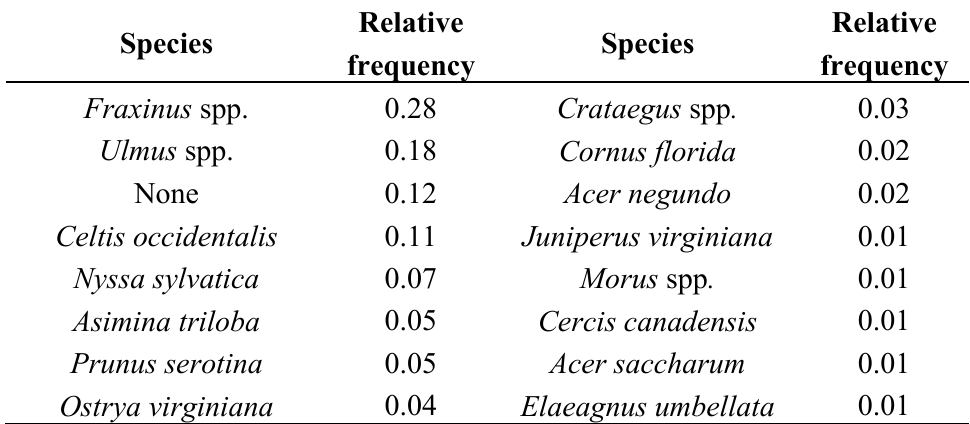
Table 3. Relative frequency, by species, of the tallest seedling classified as